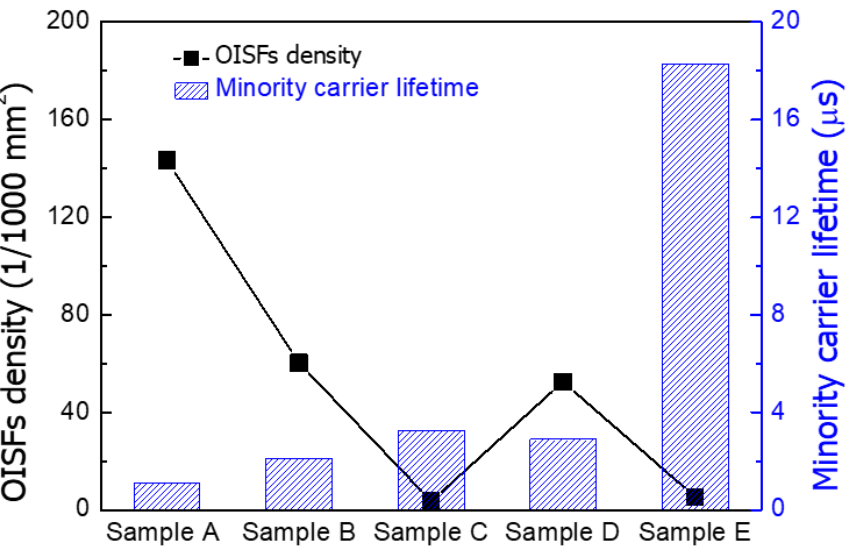
Figure 7. Relationship between average minority carrier lifetime and the number of OISFs for sam- ples A, B, C, D, and